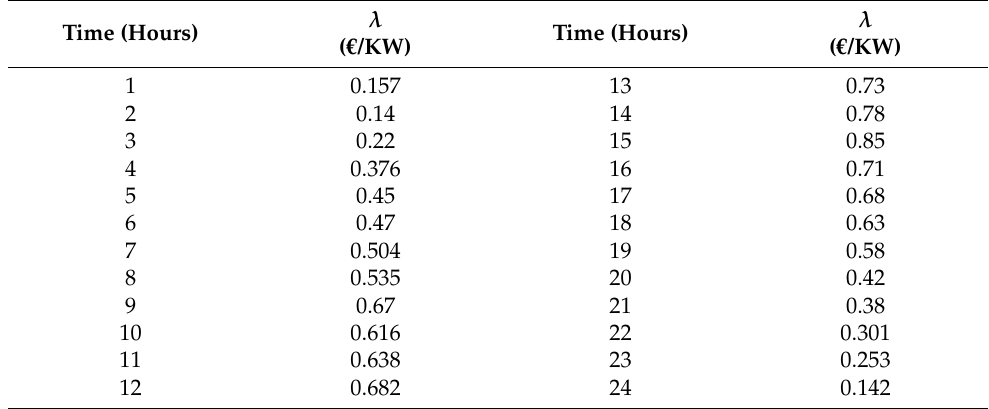
Table 4. Hourly values of λ .